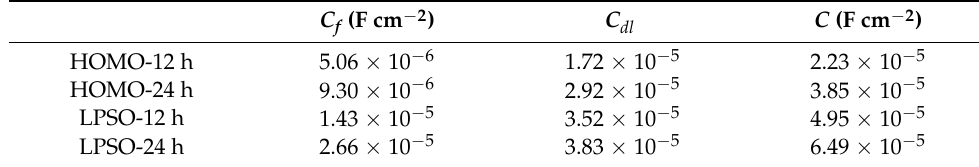
Table 2. Fitting results of the C values.